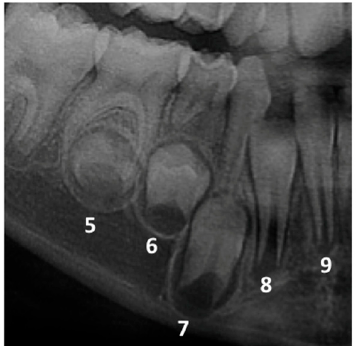
Figure 1. Nolla’s developmental stages 5, 6, 7, 8 and 9 in permanent premolars. Stage 5—crown almost completed; Stage 6—crown completed. Stage 7—1/3 root completed; Stage 8—2/3 root completed; and Stage 9—Root completed with the apex open.